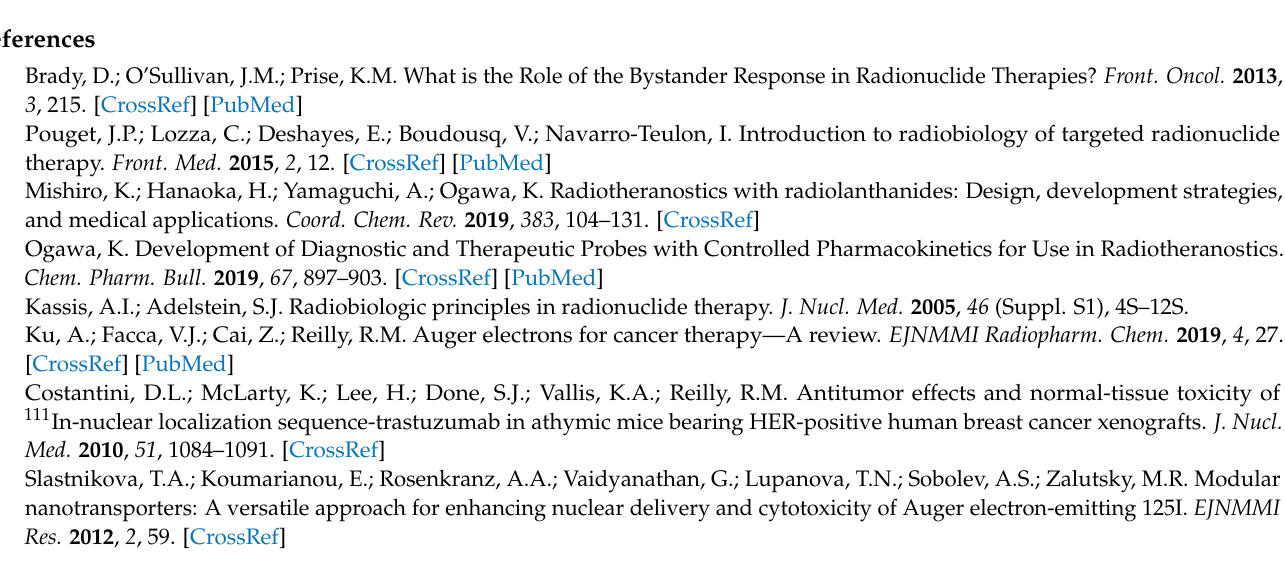
Figure S3: The stability of [ 125 I] 1 and [ 125 I] 5 in PBS. Figure S4: Cytotoxicity assay. The cytotoxicity of 5 toward Colon 26